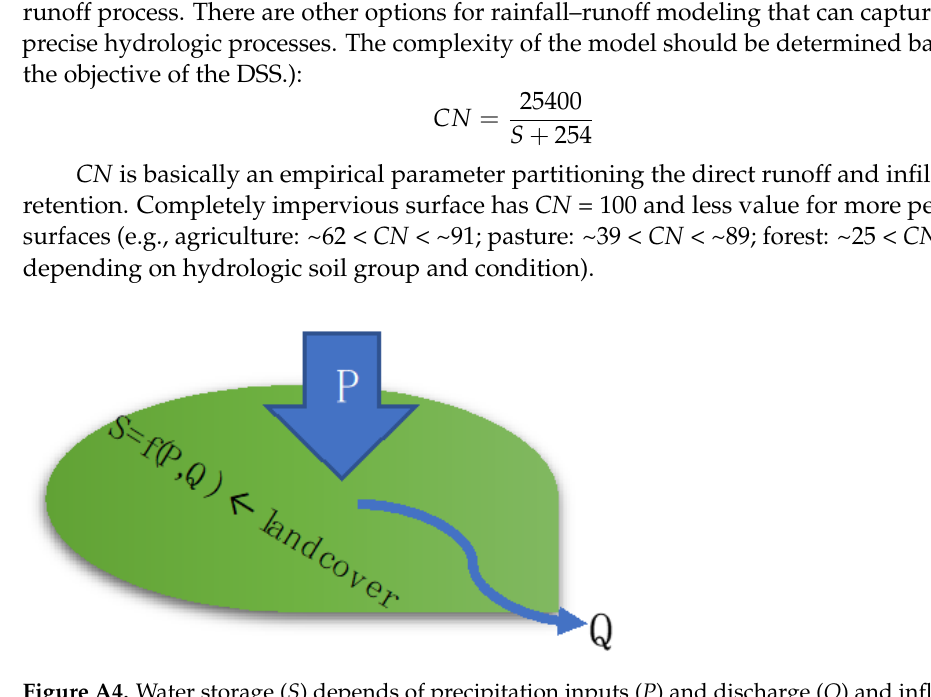
by Figure A4. Water storage ( S ) depends of precipitation inputs ( P ) and discharge ( Q ) and influenced by landcover